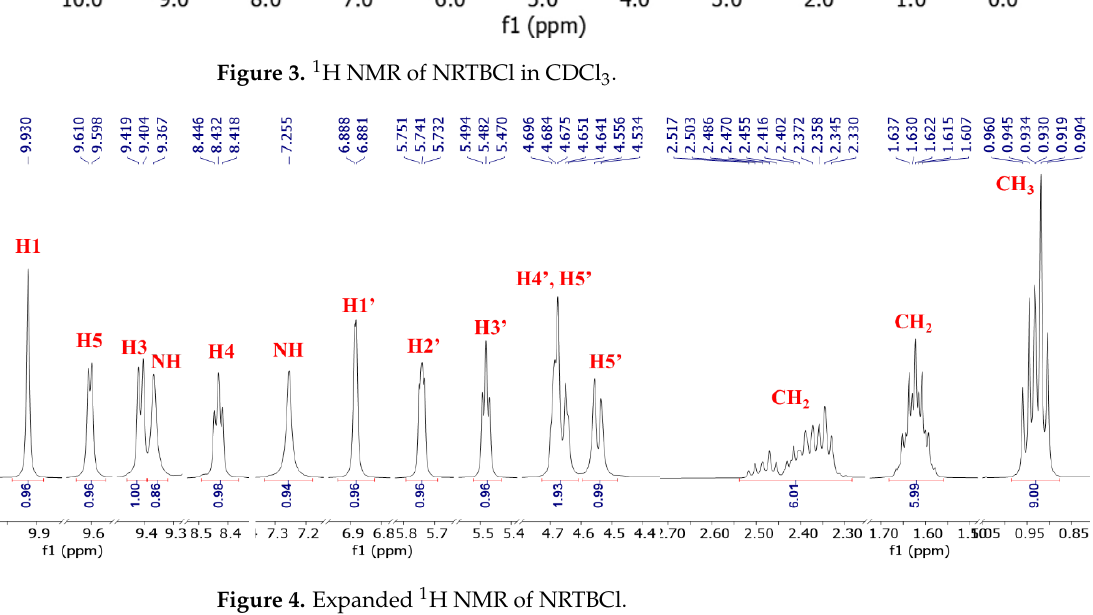
Figure 3. 1 H NMR of NRTBCl in CDCl 3 .